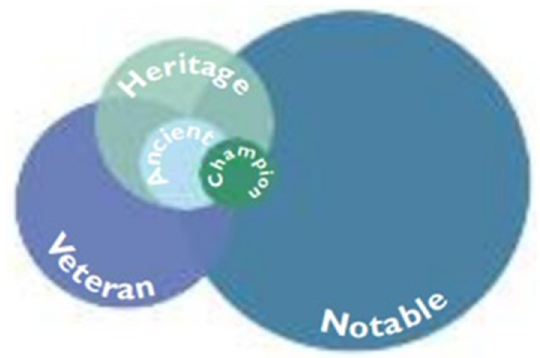
Figure 4. Significant trees according to Ancient Tree Forum [4].